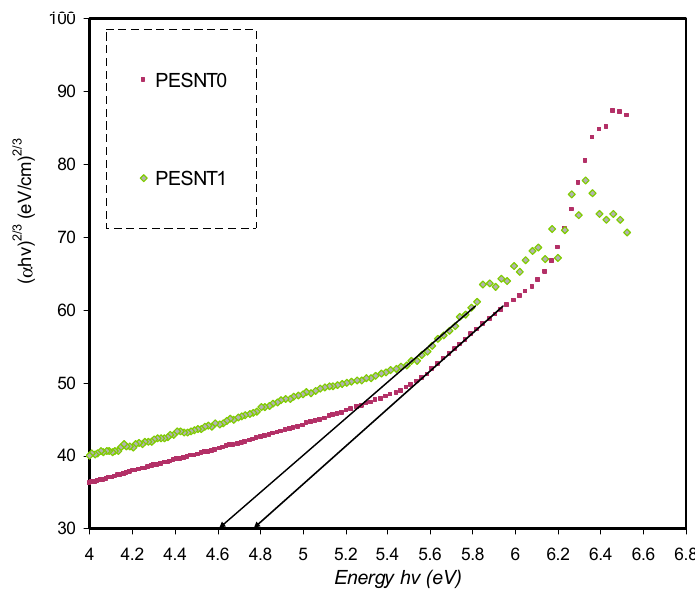
Figure 8. ( α h υ ) 1/2 in opposition to energy of photon for pure PEO (PESNT0) and doped (PESNT1) samples.